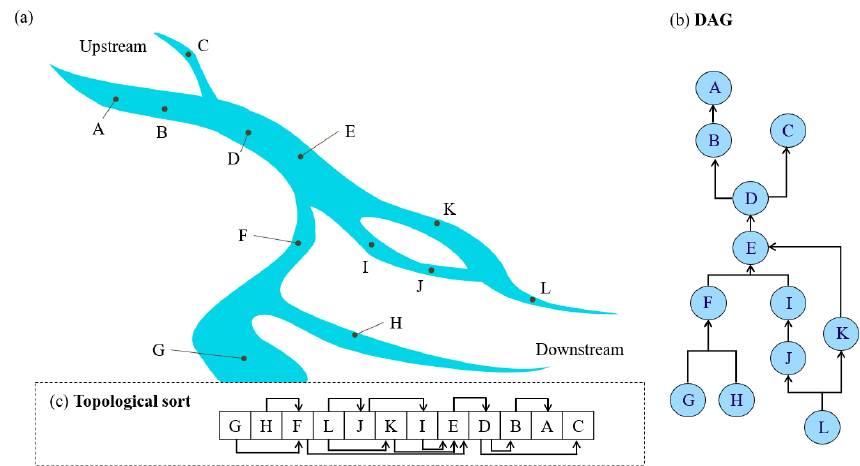
Figure 4. The upstream-downstream relationship between monitoring stations as a Directed Acyclic Graph (DAG) with the corresponding topological sort order ( a ) stream system, ( b ) DAG, ( c ) Sort.